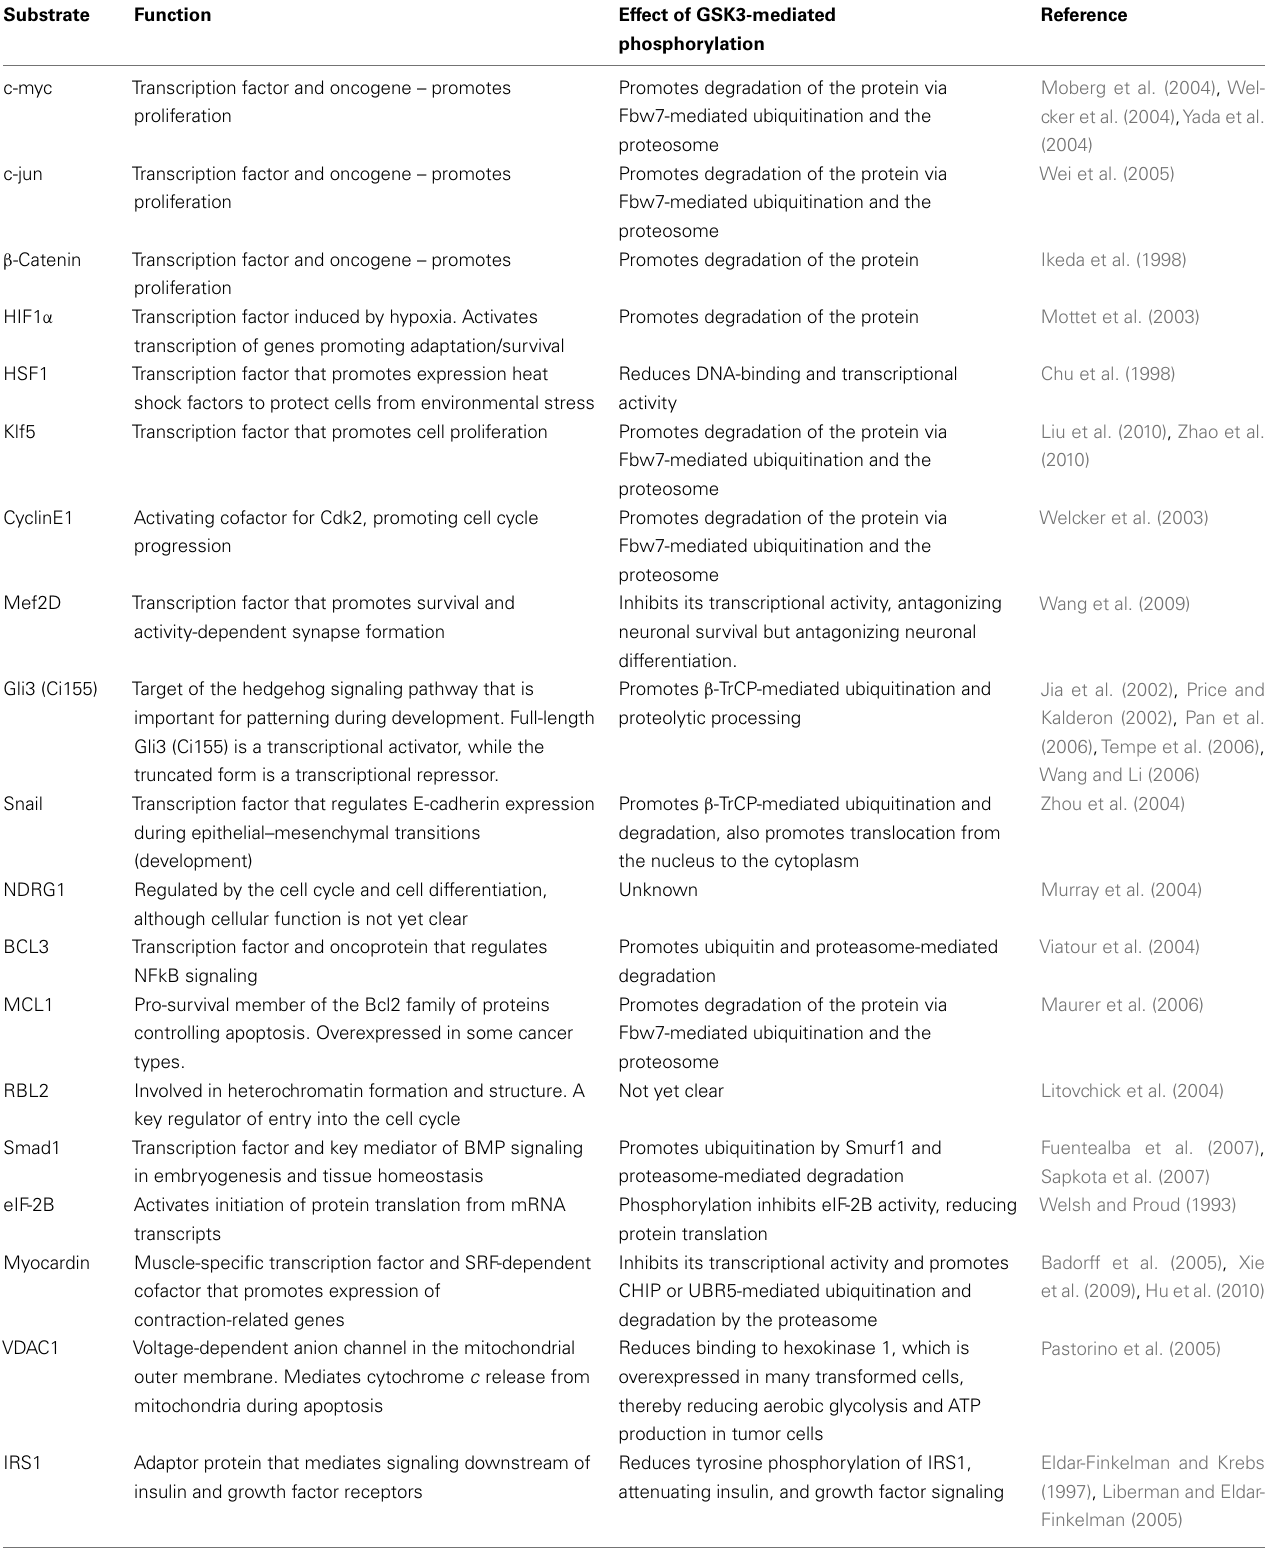
Table 1 | Substrates involved in proliferation/survival that are negatively regulated by